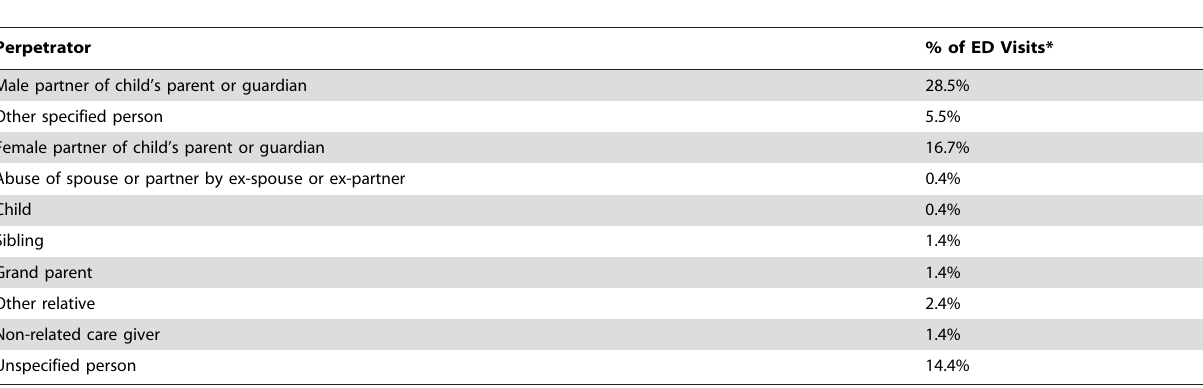
Table 3. Perpetrators of Physical